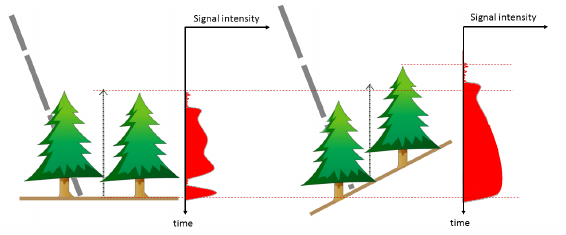
Figure 24. Effect of strong slope on LIDAR profiles.